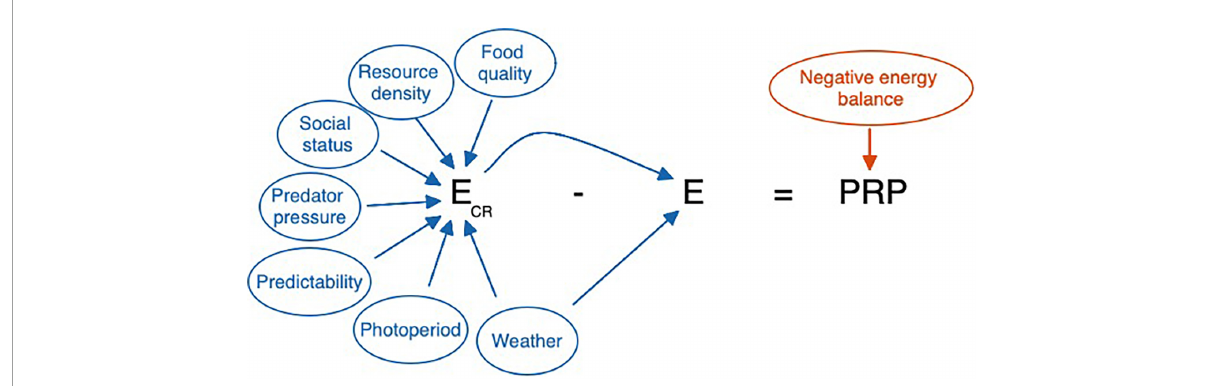
FIGURE7 Cues that may be used by a highly responsive individual, such as a non-reproductive animal, in determining whether a perturbation merits activation of the HPA axis. E cr , cumulative resource availability, may be higher or lower for an individual based on the status of any of the parameters used as cues. E cr is itself a cue for allostatic load, E, because reduced resource availability often increases the workload necessary to meet energetic requirements. Weather can both influence food availability (e.g., covering food, making insects or predators less active) and offer predictive information about allostatic load (if it’s cold, it is going to be an expensive day). In the absence of predictive cues, prolonged negative energy balance will provide the direct and corrective cue indicating that a false negative error has occurred, and the perturbation resistance potential (PRP) is less than zero. However, for some individuals a response at this point may be too late. Note that here E = E e + E i . Variation in E e and E i can directly affect E and thus PRP. When E o occurs as well, this would increase E further and reduce PRP. E e , E i , and E o can all vary independently affecting E , and thus PRP, in different ways. Here we focus on E = E e + E i .